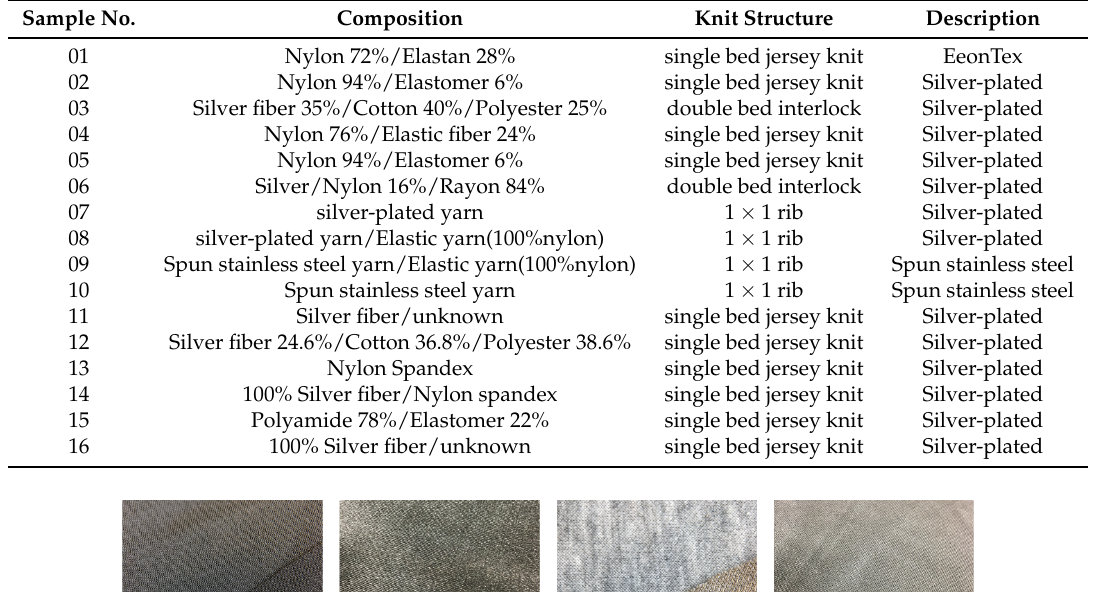
Table 1. Summary of samples.